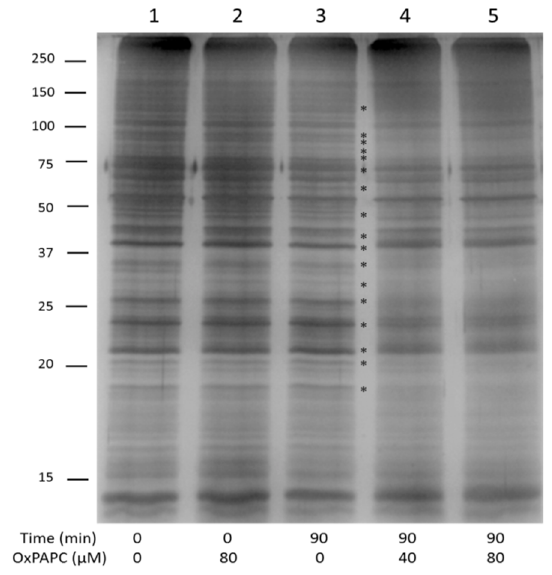
Figure 2. Gel band shift analysis of PBS-insoluble/RIPA-soluble HUVEC proteins. OxPAPC incubated with proteins for 90 min significantly changed the electrophoretic protein profile (lanes 4 and 5). OxPAPC which is not covalently bound to proteins does not influence the electrophoretic mobility of proteins (lane 2). Lane 1: control sample time point 0; lane 3: control sample time point 90. The final OxPAPC concentration in treated samples was 40 and 80 µ mol/L. Main visible changes are marked with